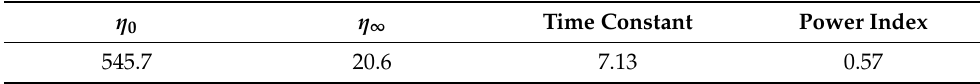
Figure 6. Shear-rate viscosity curves of the experiments, the user defined curve* (ALE) and the CROSS II- approach for the ICFD solver. (*infinity viscosity η ∞ of 20.6Pa · s at ˙ γ = 4 × 10 35 s − 1 for numerical stability is not printed). Table 3. Parameters of the CROSS—model for ICFD